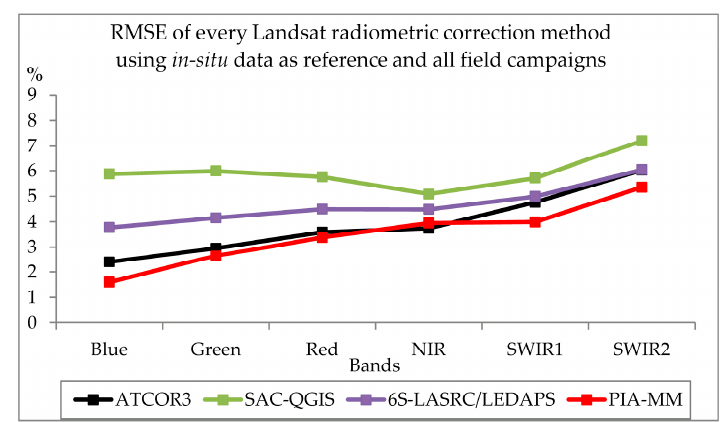
Figure 9. Band-by-band Root Mean Square Error of each radiometric correction method analyzed for Landsat images, grouping all dates.